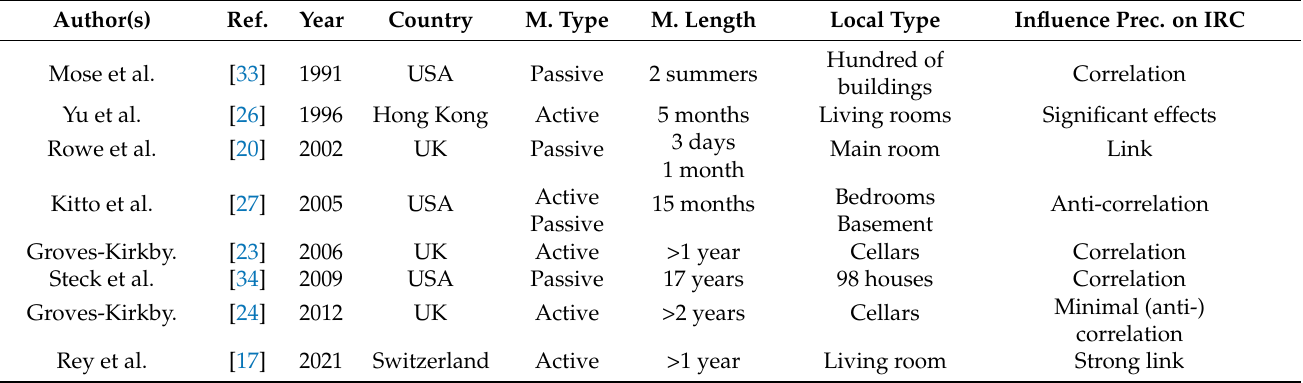
Table 3. Synthesis of precipitation influences on IRC highlighted in a selected literature. (Ref.: references; M.: measurements; Prec: precipitation).